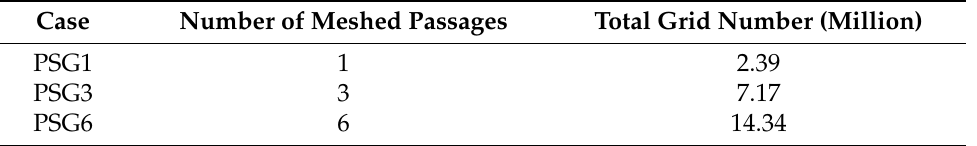
Table 3. Mesh setup of different numerical